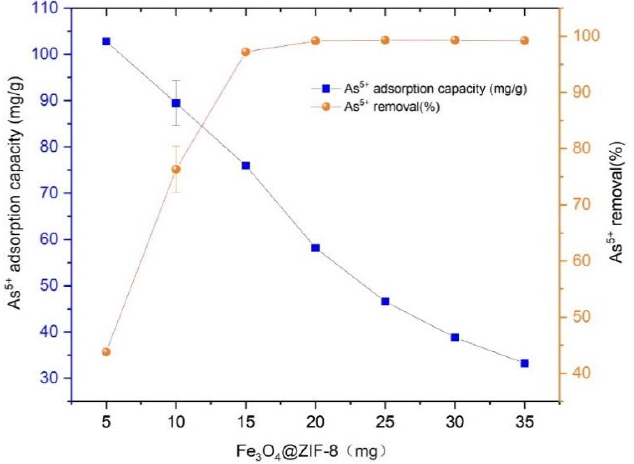
Figure 1. The adsorption effect of adsorbent dose.